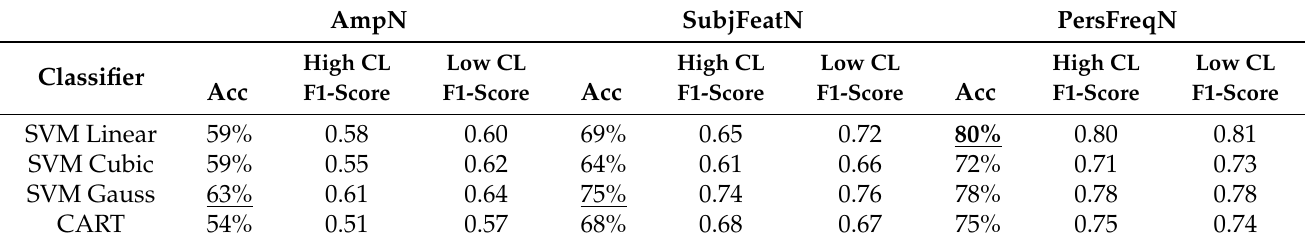
Table 6. Performance comparison on CLAWDAS Elderly, varying the normalization strategies (columns) and classification models (rows). Two performance metrics are evaluated using a LOSO validation strategy: Accuracy (Acc) and single-class F1-score. The best performances reached for each type of normalization are underlined, while the the highest accuracy value of all is highlighted in